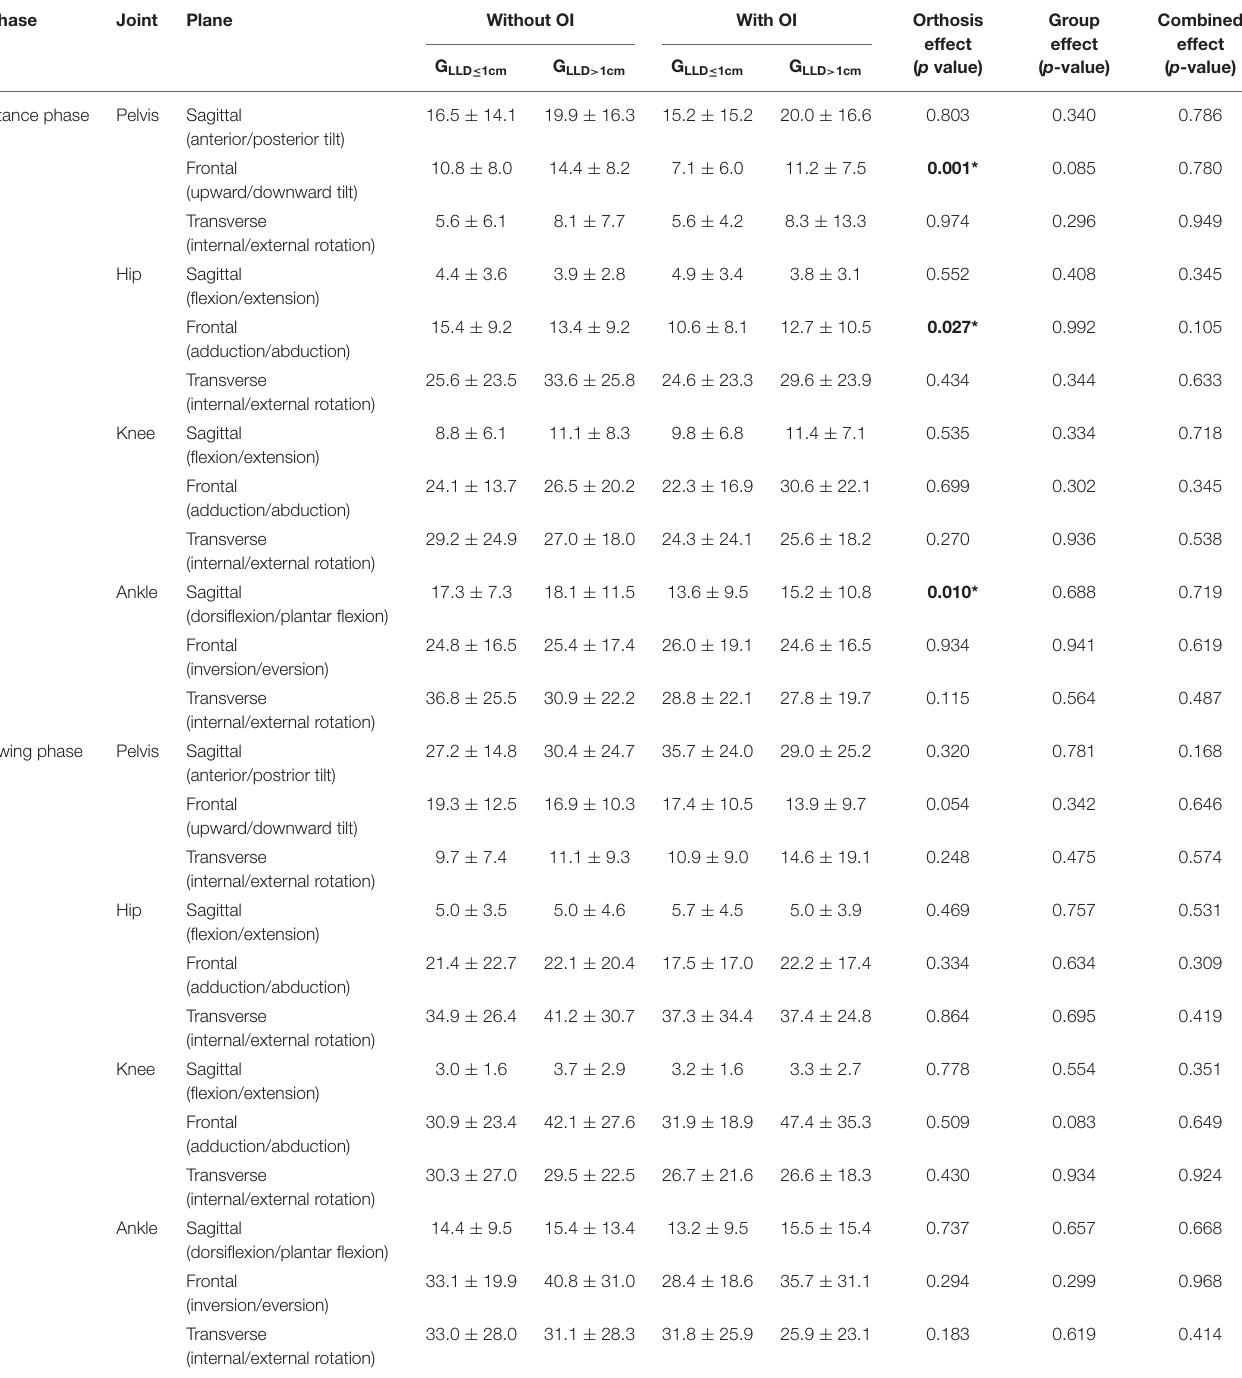
TABLE 2 | Symmetry index (with joint range of motion) between the longer and shorter legs for the sagittal, frontal, and transverse planes for the pelvis, hip, knee, and ankle with or without orthotic insoles (OIs) in both groups during the stance and swing phases. Phase Joint